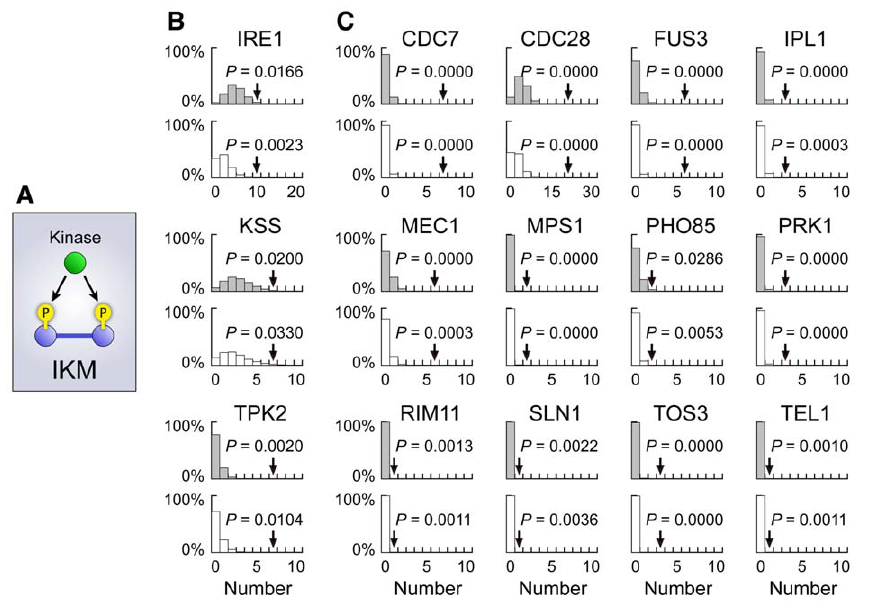
Figure 7. Kinases inferred to yield co-phosphorylation of proteins in the same protein complex. ( A ) Conceptual diagram of an interacting kinate module (IKM) motif. ( B,C ) Kinases revealed to have significantly higher IKM formability than negative controls by data integration of the PPI network with in vitro kinase–substrate relationships ( B ) and with a literature-based collection of signaling pathways ( C ). For each kinase, arrows denote number counts of IKMs formed by that kinase and the ‘‘whole’’ (i.e. unfiltered) PPI network, with P values estimated from negative controls of the PPI network generated by RER and NLS (N=10,000). Expected probability density distributions of number counts of IKMs observed in negative controls generated by node label shuffling and random edge rewiring are shown by gray and white bars,